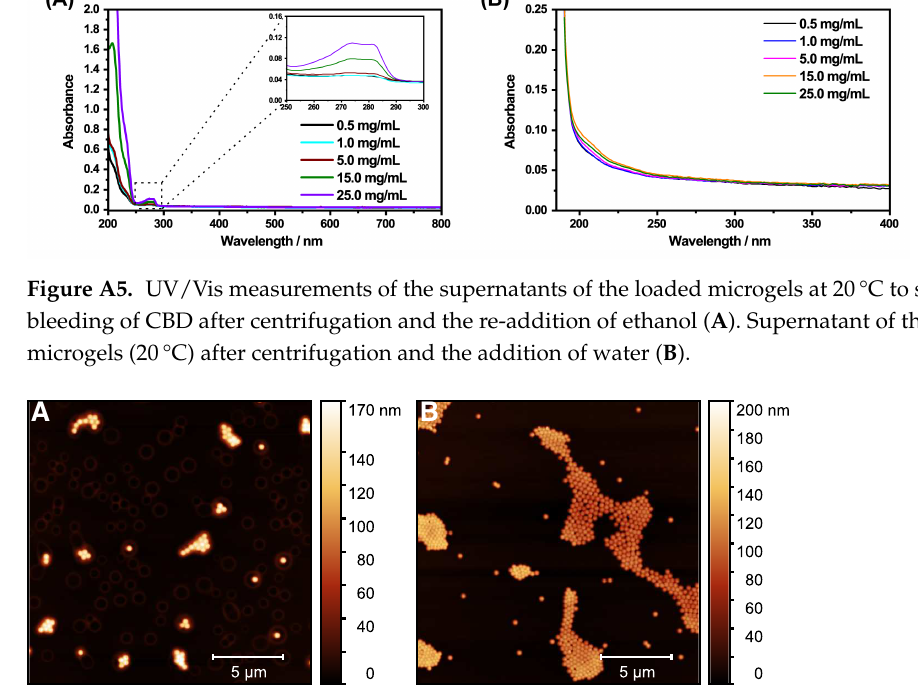
Figure A6. AFM height images (20 × 20 µ m) for the microgel particles in ethanol/CBD solution ( A ) and after the release of CBD in ethanol solution ( B ). The measurements were performed in the dried state at room temperature. The images were used to extract height profiles of the microgel particles using the software GWYDDION.